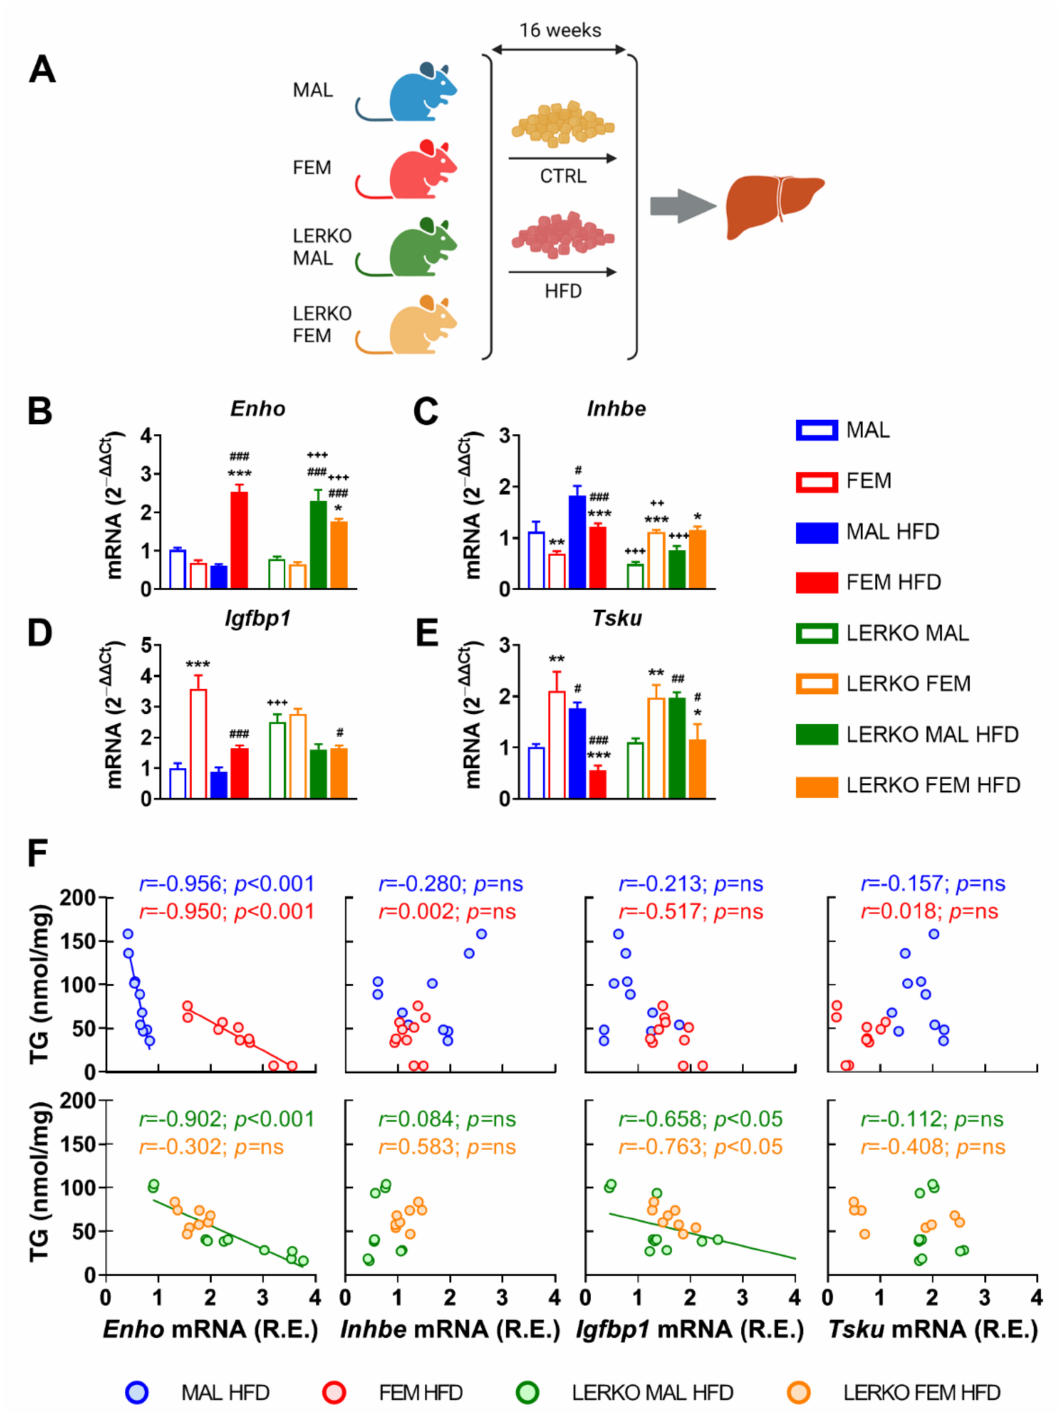
Figure 4. Enho mRNA levels negatively correlate with fatty liver in a HFD-induced mouse model of NAFLD. ( A ) Experimental design adopted to evaluate the relevance of estrogen signaling in the liver metabolic response to a high-fat diet (HFD). ( B – E ) mRNA contents of Enho ( B ), Inhbe ( C ), Igfbp1 ( D ), and Tsku ( E ) measured by RT-PCR in the liver of male and female control and LERKO mice fed with control diet or HFD. Data are presented as mean ± SEM ( n = 8–10). * p < 0.05, ** p < 0.01, and *** p < 0.001 females vs. males; # p < 0.05, ## p < 0.01, and ### p < 0.001 HFD vs. control diet; ++ p < 0.01 and +++ p < 0.001 LERKO vs. control mice by two-way ANOVA followed by Bonferroni’s post hoc test. ( F ) Pearson’s correlation and linear regression between liver triglyceride (TG) content and relative expression (R.E.) of Enho , Inhbe , Igfbp1 , and Tsku mRNA levels measured in the liver of male and female control and LERKO mice fed with